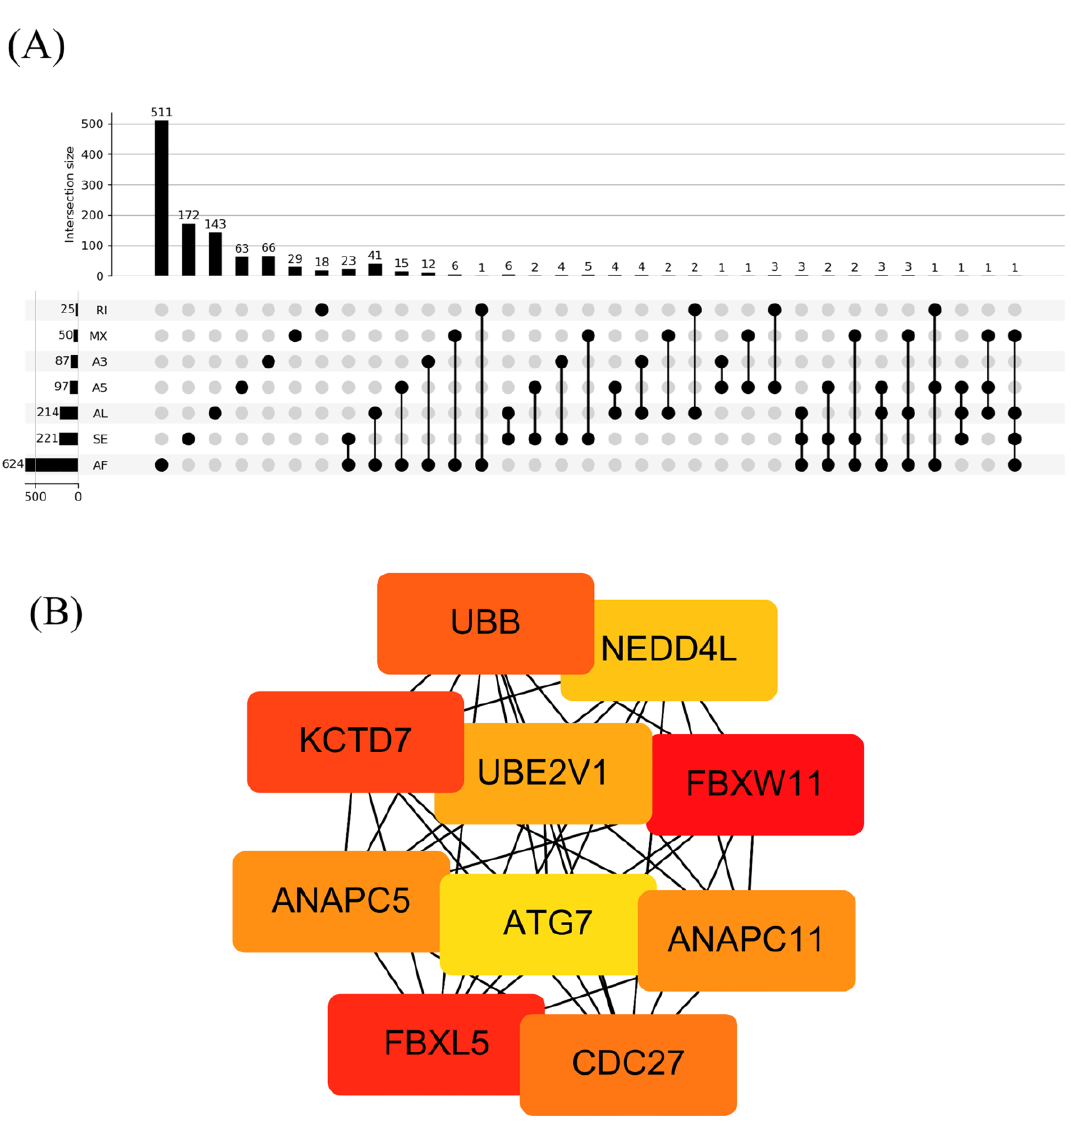
Figure 4. Summary and gene network of OS-related AS events. ( A ) UpSet intersection diagram showing the seven types of OS-related AS events. ( B ) Hub gene screening.